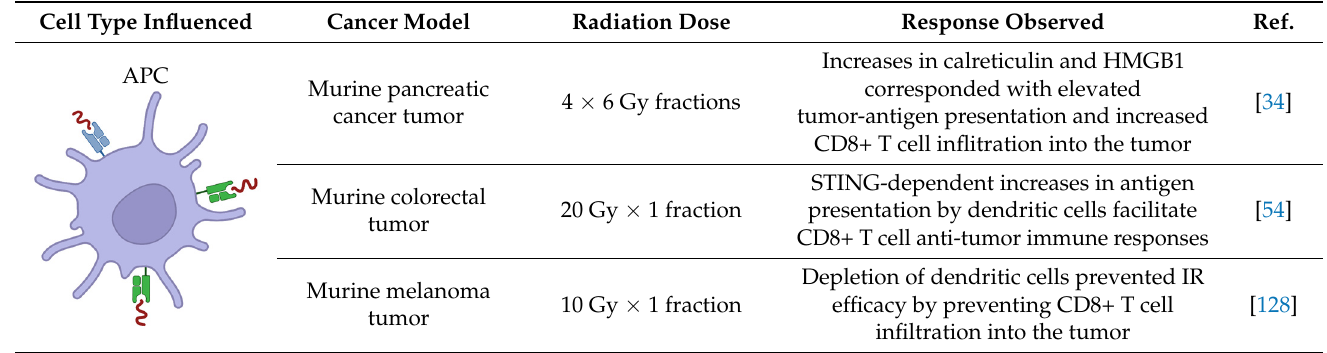
Table 1. Highlighting the effects of IR on various immune cell types. Different immune cell types from the tumor microenvironment are listed, along with examples of reported effects of IR on their function. Cell Type Influenced Cancer Model Radiation Dose Response Observed Ref.